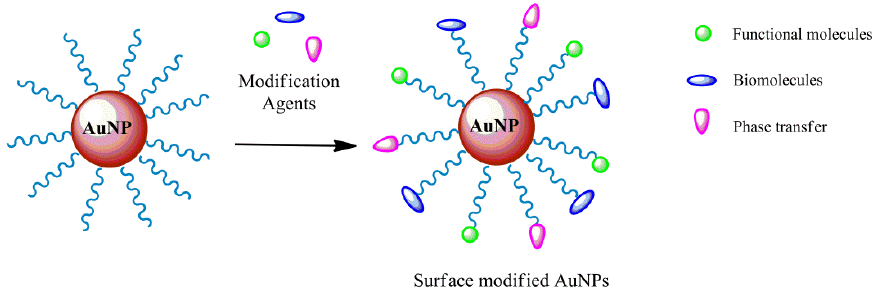
Figure 3. Multi–functional modification of AuNPs surface.